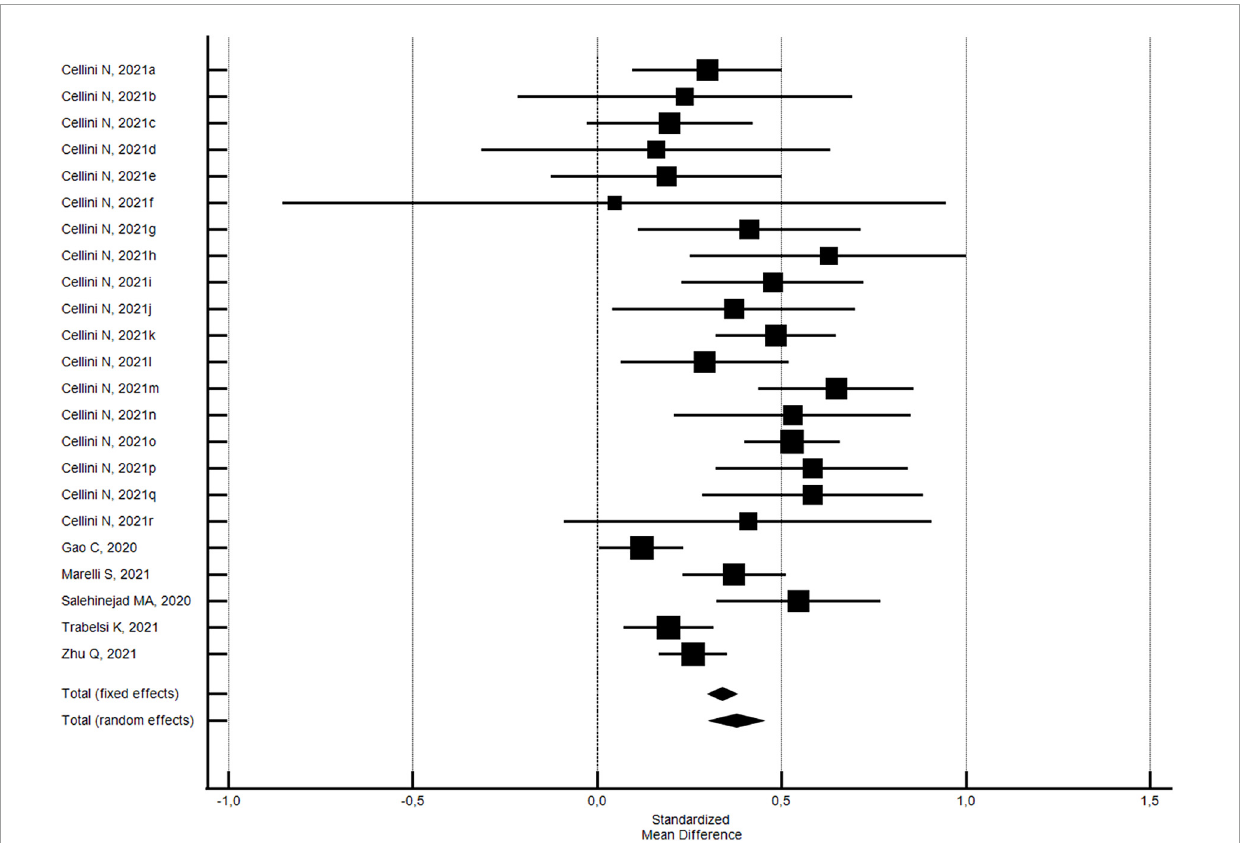
FIGURE5 Forest plot showing pooled changes in sleep onset latency from before to during the COVID-19 lockdown. Cellini N, 2021a: Belgian Students, Female; Cellini N, 2021b: Belgian Students, Male; Cellini N, 2021c: Belgian Regular workers, Female; Cellini N, 2021d: Belgian Regular workers, Male; Cellini N, 2021e: Belgian Remote workers, Female; Cellini N, 2021f: Belgian Remote workers, Male; Cellini N, 2021g: Belgian Unemployed/retired, Female; Cellini N, 2021h: Belgian Unemployed/retired, Male; Cellini N, 2021i: Italian Students, Female; Cellini N, 2021j: Italian Students, Male; Cellini N, 2021k: Italian Regular workers, Female; Cellini N, 2021l: Italian Regular workers, Male; Cellini N, 2021m: Italian Remote workers, Female; Cellini N, 2021n: Italian Remote workers, Male; Cellini N, 2021o:Italian Stop working, Female; Cellini N, 2021p: Italian Stop working, Male; Cellini N, 2021q: Italian Unemployed/retired, Female; Cellini N, 2021r: Italian Unemployed/retired, Male. Error bars = 95% confidence interval; Square boxes = individual study effects; and Diamond box = Pooled